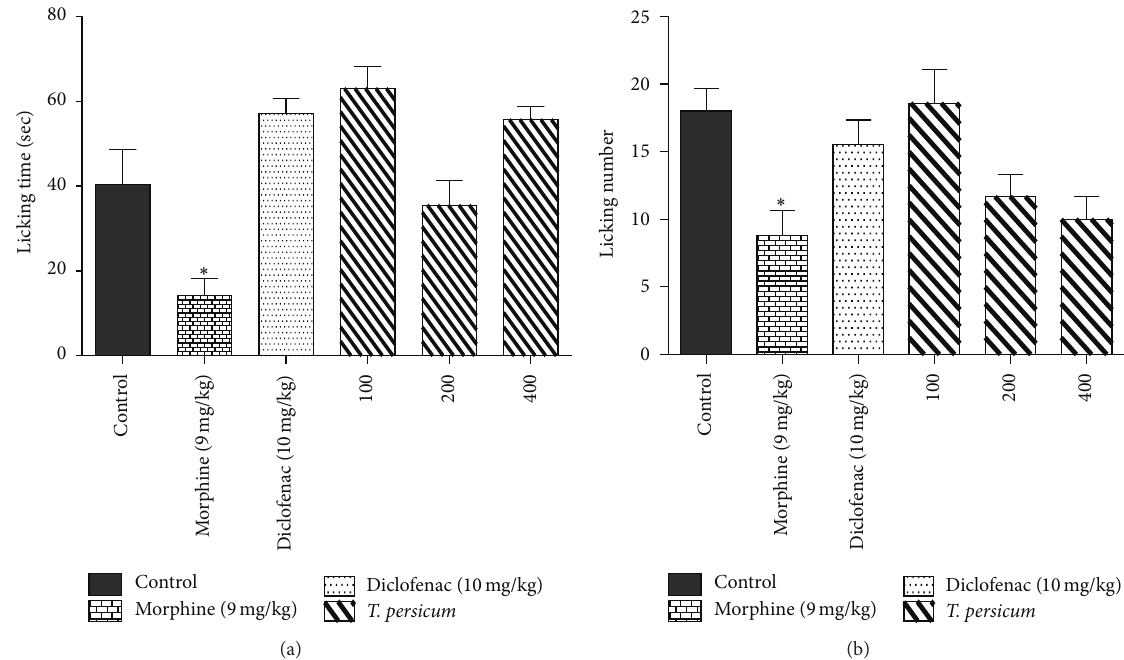
Figure 1: Effects of TPE, Morphine (9mg/kg), and Diclofenac (10mg/kg) in the acute phase of the formalin test in mice by assessing the licking time (a) and the number of lickings (b). ∗ 𝑃 < 0.05 , ∗∗ 𝑃 < 0.01 , and ∗∗∗ 𝑃 < 0.001 significantly different from the control animals. Each value represents the mean ± SEM ( 𝑛 = 8